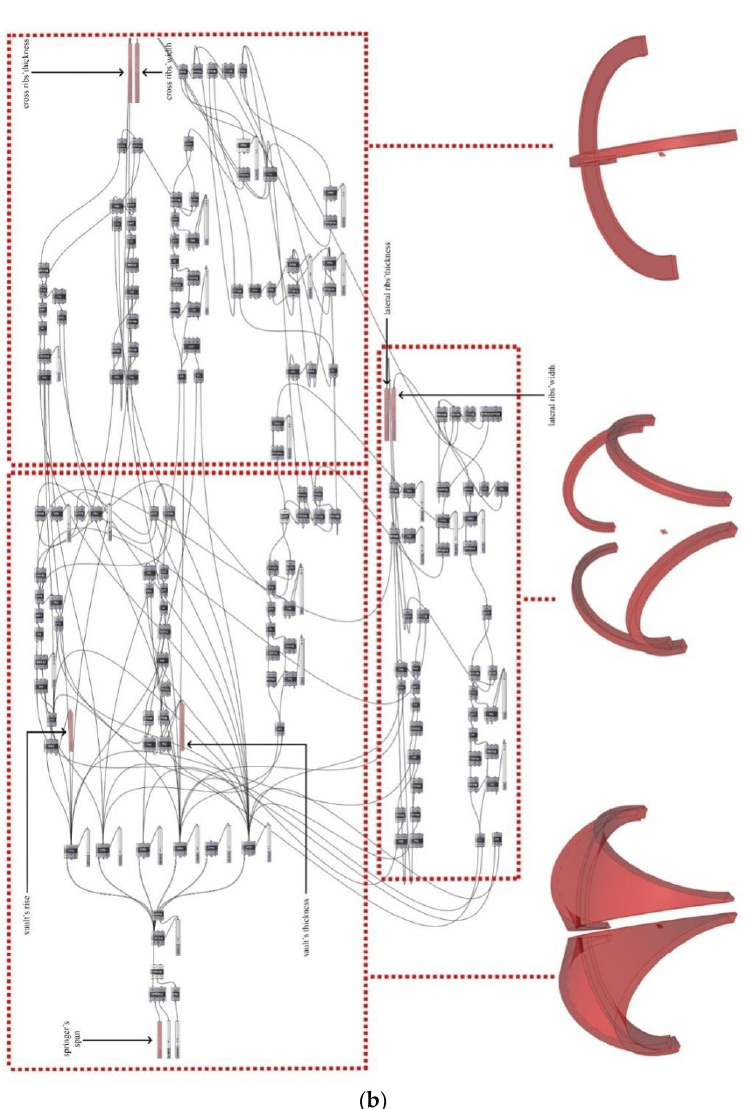
Figure 12. Generative algorithms for vaults, example of a cross vault generation; the geometrical parameters are shown in red and commands’ groups are linked with the associated 3D modeling outcomes: ( a ) Preliminary algorithm for barrel, cross and cloister vaults with regular or irregular shape and mixed features; ( b ) Refined algorithm adding the side and diagonal stiffening ribs according to vault’s type.